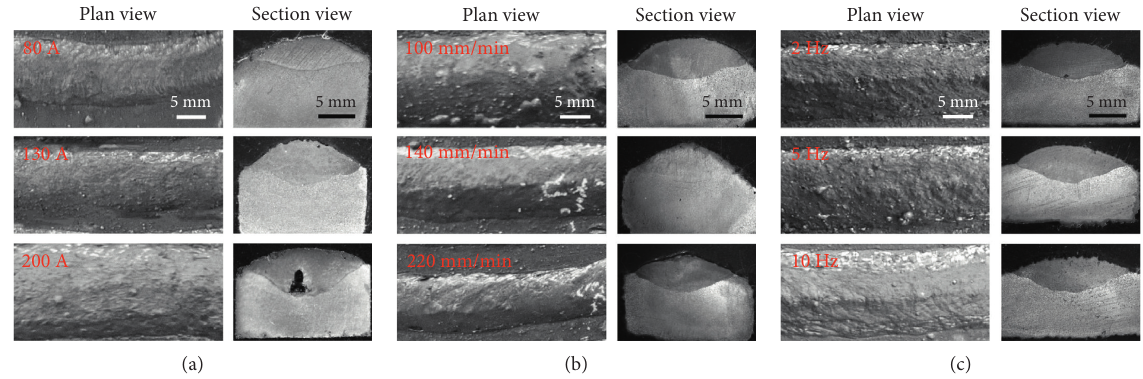
Figure 5: Digital photos of the Q235 steel pipe cladded by the AW-LSF.